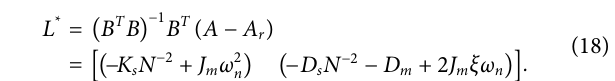
Frontiers in Robotics and AI |